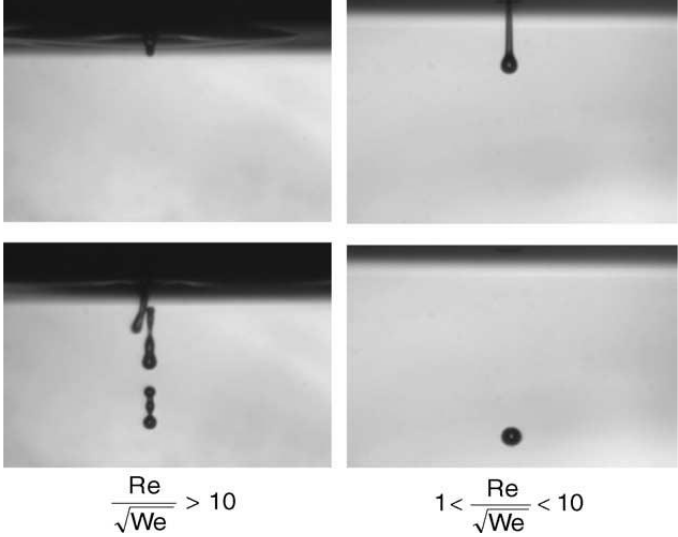
Figure 4. Ejection images of suspensions showing the effect of the ratio Re/We 1/2 (Z value) [25]. The binder system’s surface tension should be high enough to form droplets and prevent binder leakage when the print nozzle is not used. Second, the viscosity of the binder plays a significant role in the preparation’s formation. If the viscosity is too high, there will be a high injection pressure, resulting in the uneven injection of the printing liquid and nozzle blockage. If the viscosity is too low, satellite droplets will form, and prepara- tions will print unevenly [28,29]. The amount of binder is also a factor affecting the print- ing process. Too much binder will stick to excess powders, resulting in an incorrect prep- aration size. When the amount of binder is insufficient, the preparation has poor mechan- ical properties [30]. 2.1.3. Powder-Specific Properties The foundation of the binder jet 3D printing is powder material. Powder-specific properties strongly influence many aspects of the binder jetting process. Therefore, it is vital to ensure the uniform distribution and packing of the powder in the powder bed. The significant characteristics of powder typically studied in binder jet 3D printing in- clude: (1) powder particle characteristics (including surface morphology and powder particle size and size distribution) (2) powder flowability, (3) powder packing density. Chen et al. [31] mentioned that spherical shape particles were the first choice in binder jet 3D printing. It could reduce the tendency of mechanical interlocking and the force of friction between particles to form a consistent powder flow, which results in an even distribution of the powder on the powder bed. Li et al. [32] explored the effect of force between particles on powder flowability. The experiment confirmed that the van der Waals force between powders with small particle sizes was large. Small particles were more prone to aggregation and poor flowability, negatively impacting powder packing density. Large particles had good flowability but will affect the uniformity of powder lay- downing and printing accuracy in the wettability and adhesion of the powder. On the other hand, the smaller the average particle size was, the higher the printing resolution would be [33]. The influence of particle size and particle size distribution of powder on the printing effect was evident, which could directly interfere with the mechanical strength and surface roughness of 3D printing preparation [34]. The flowability of the powder in binder jet 3D printing has a significant impact on obtaining high-resolution